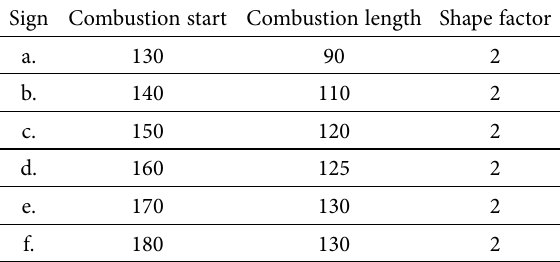
Table. Combustion processes applied for parameter analysis ( source : measurements were done by the author) Sign Combustion start Combustion length Shape